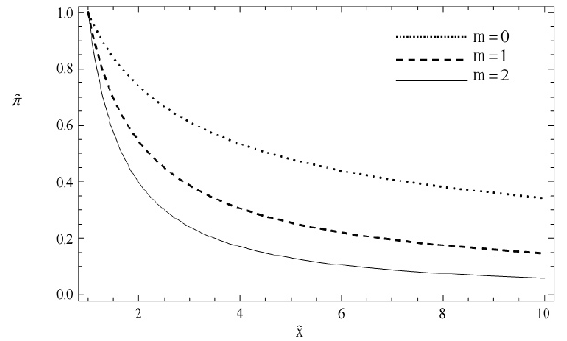
Figure 2. The decay behavior of shock strength ( 0 . 5 and γ = 5/3.